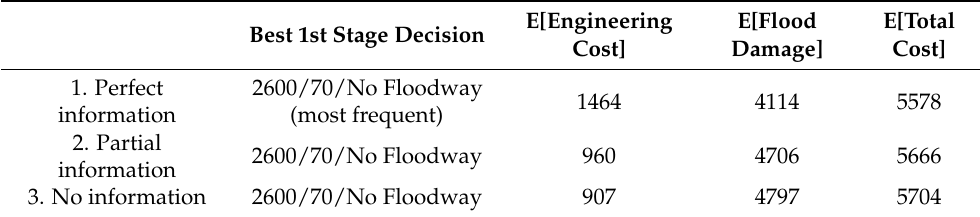
Table 10. Comparisons of robust, adaptive decision vs. decisions under perfect information (in million